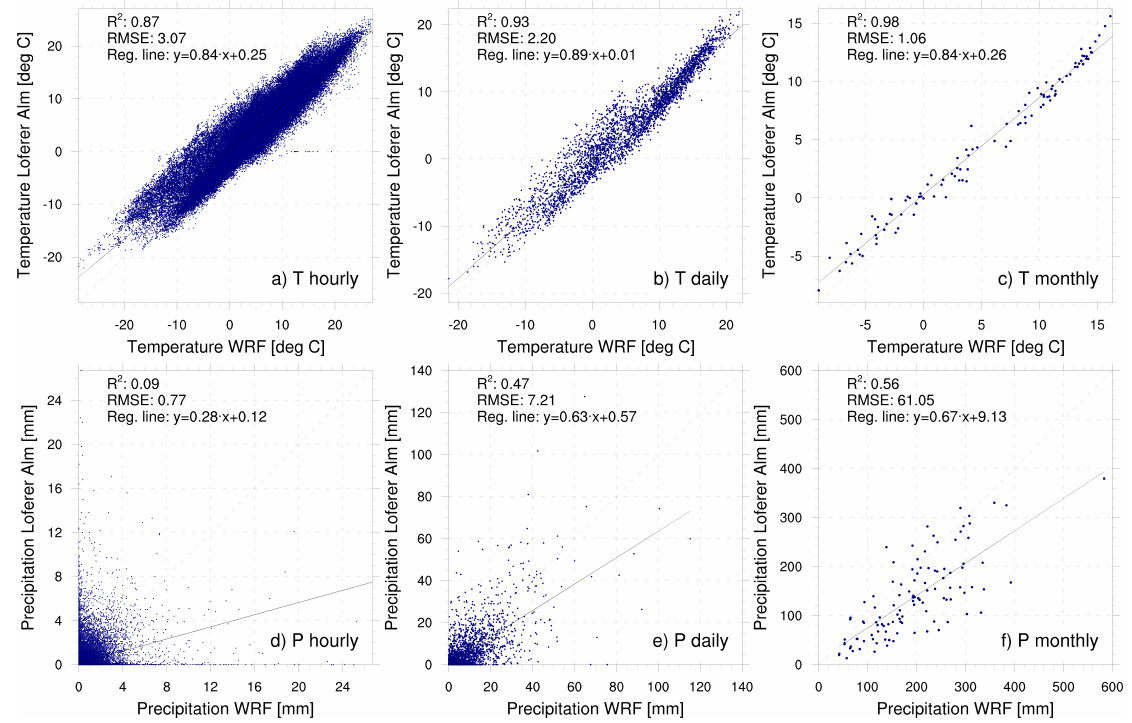
Figure 10. Scatter plot for temperature (top row) and precipitation (bottom row) modeled and measured at the station Loferer Alm (1623 m ASL) for the period 2001–2009. From left to right the panel shows hourly, daily, and monthly aggregated